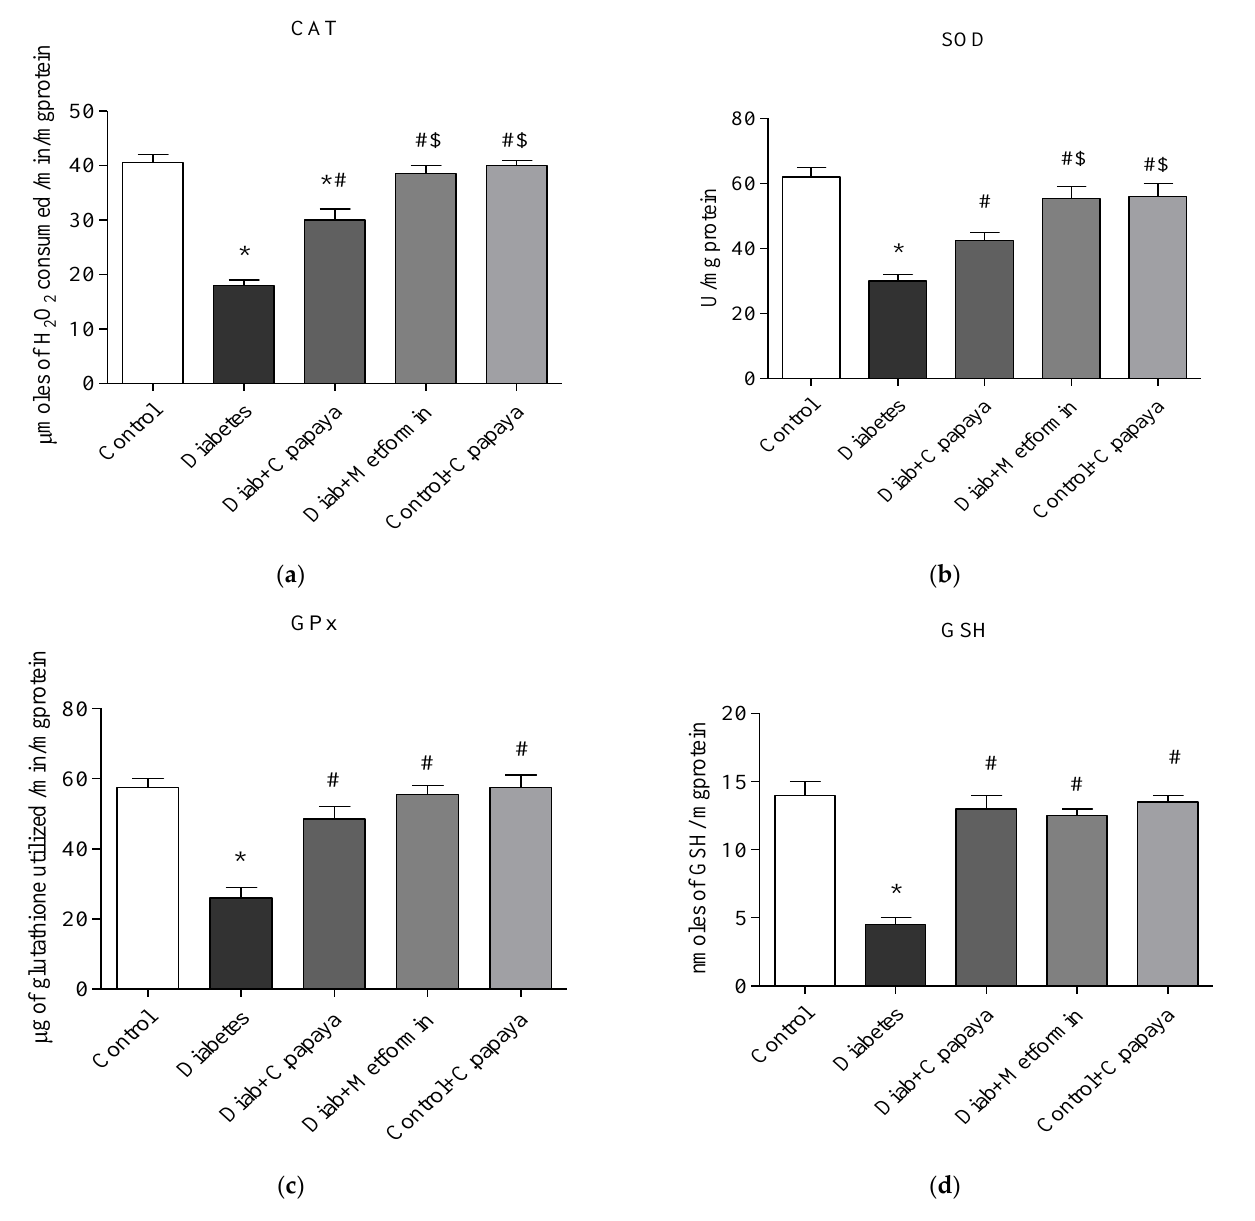
Figure 7. ( a – d ) Role of C. papaya on enzymatic antioxidants levels. p < 0.05 was considered statistically significant among the groups: *-control; #-diabetes; $- C. papaya -treated